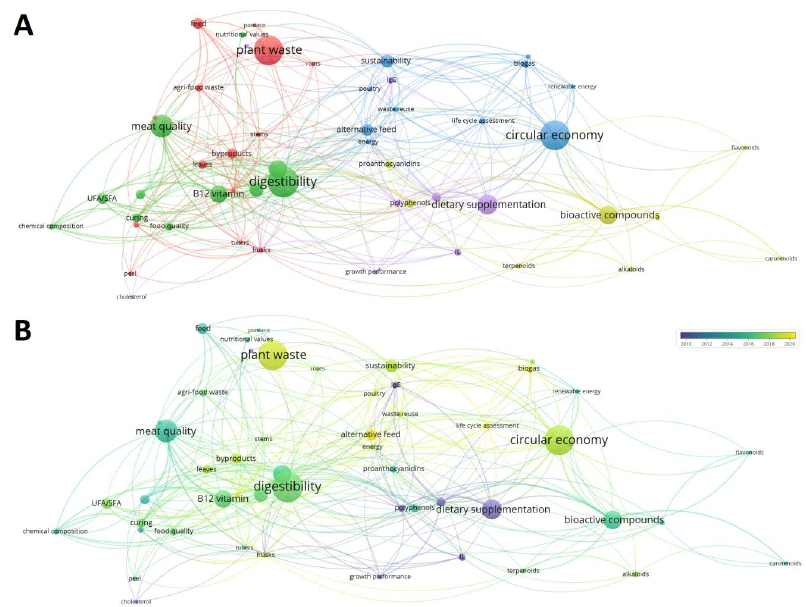
Figure 5. Co-occurrence map showing the existing networking of terms reported as keywords in publications related to the inclusion of agri-food waste in swine diets. ( A ) shows clustering in five different groups. ( B ) shows the same network from a temporal perspective. The size of the nodes indicates their frequency. The curves between nodes represent their co-occurrence in the same pub- lication.